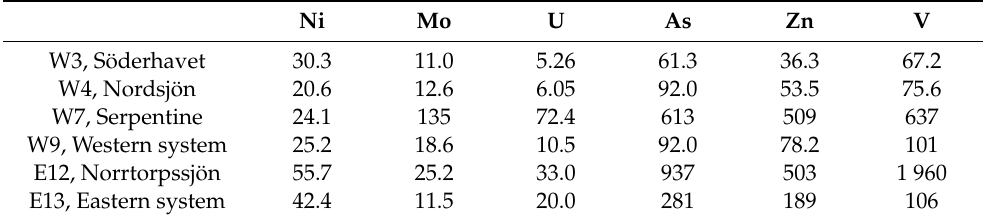
Table 9. Theoretical factors indicating how much higher the primary release from the waste materials in the catchment area is compared to the total mass transport in the surface sampling point. Release rates based on the trace elements / sulfate ratios ( µ g / L / mg / L) (Table 8). It has been assumed that the eastern catchment contains shale, fines and shale ash while the western catchment only contains shale and fines.